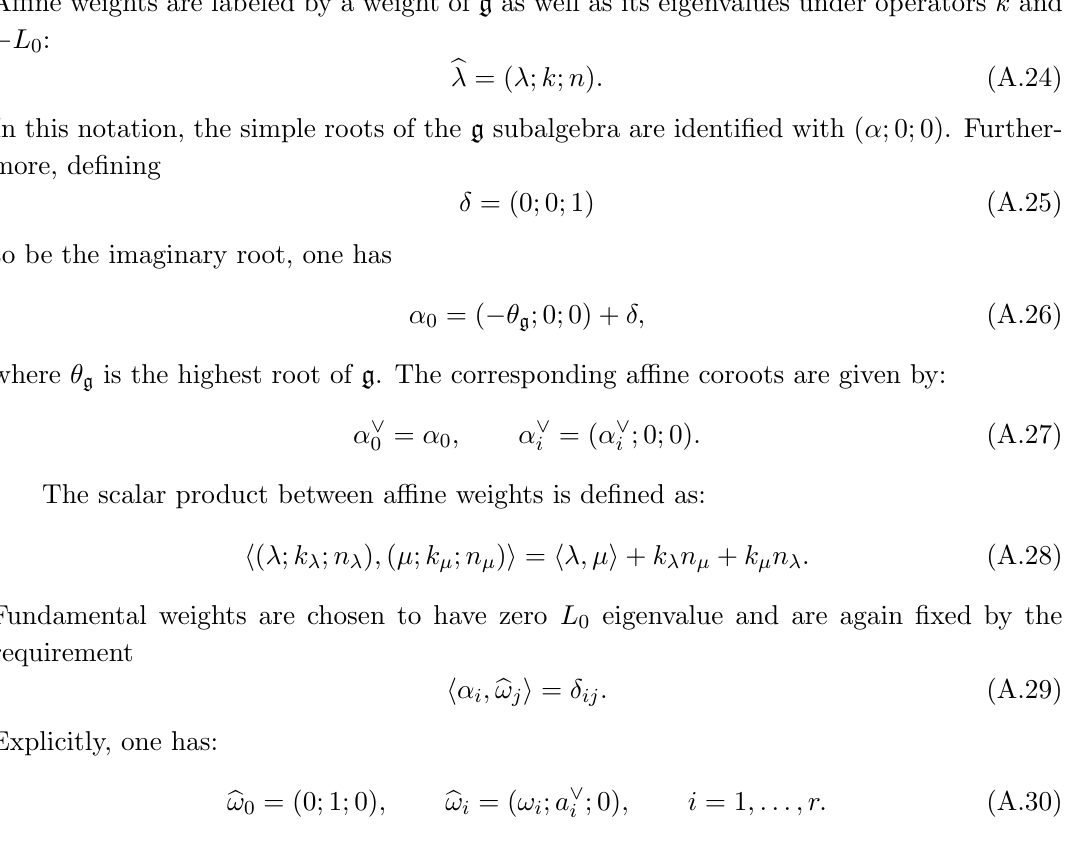
Figure 18. Dynkin labels associated to a(cid:14)ne Lie algebras. We label the i -th node by ( i; a _ where a _ are the i